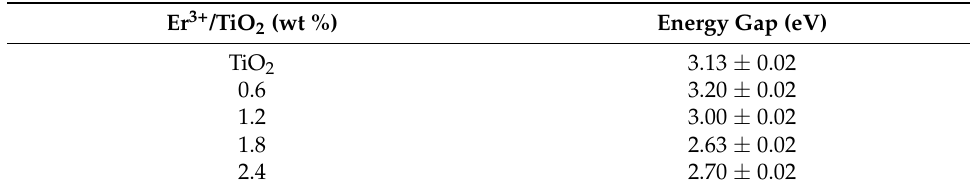
Figure 6. Calculation of the direct band gap energy obtained in our study. Table 4. Energy gaps for the synthesized Er 3+ /TiO 2 NP samples.